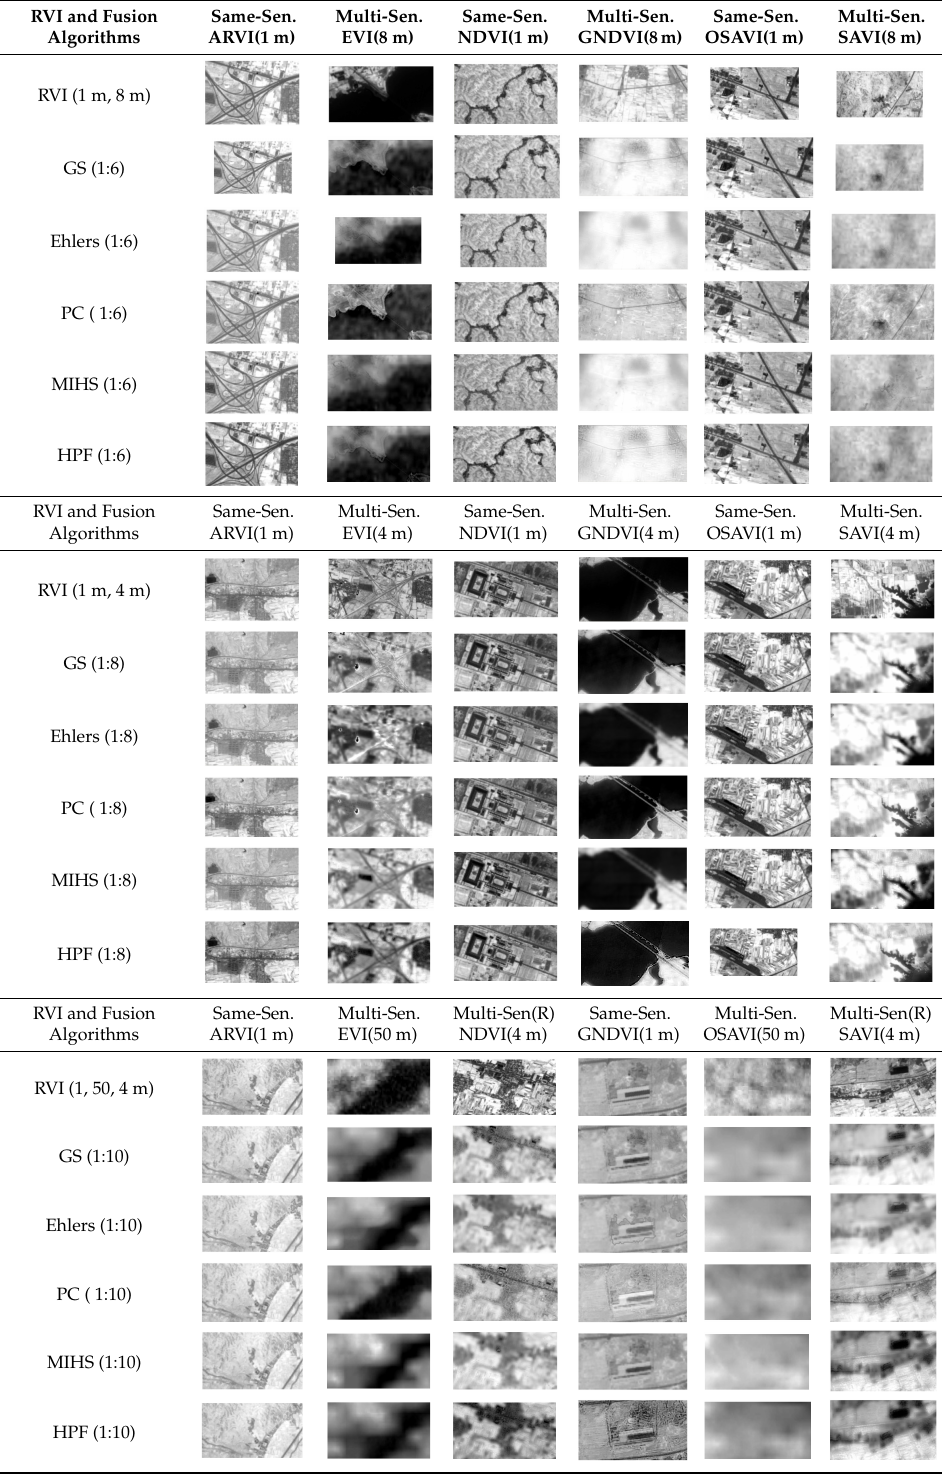
Table 8. Visual quality of FVI result in single/multi-sensor